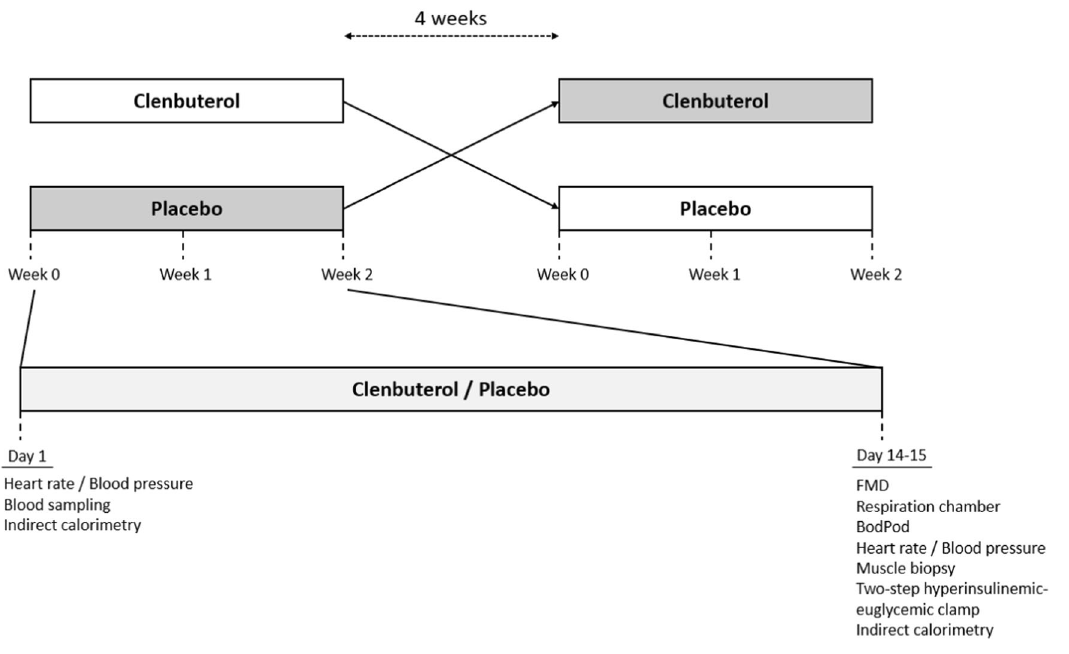
Fig. 9 | Overview study design. FMD fl ow-mediated